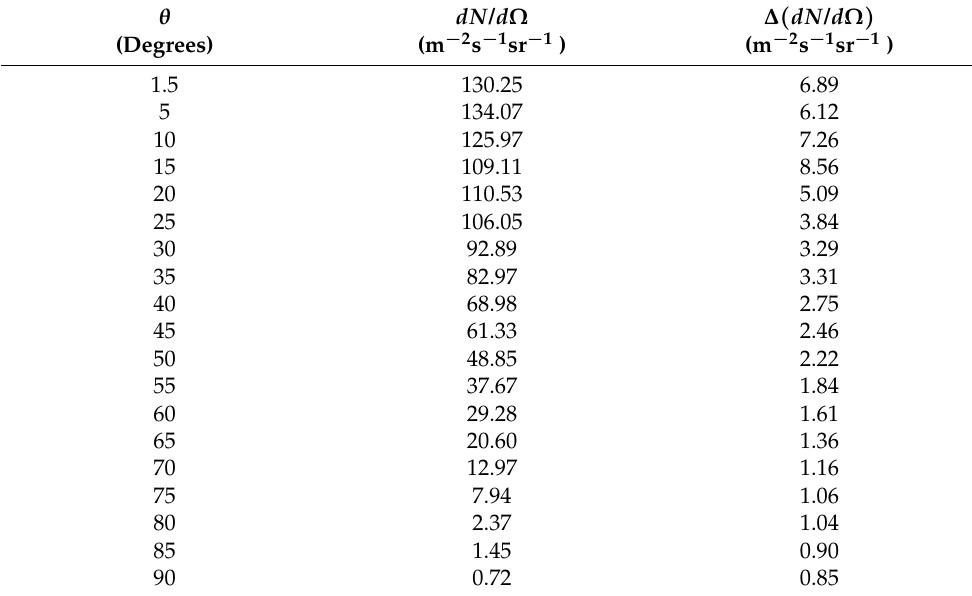
Table 2. Muon flux measurements for the different zenith angles and the corresponding flux uncer-